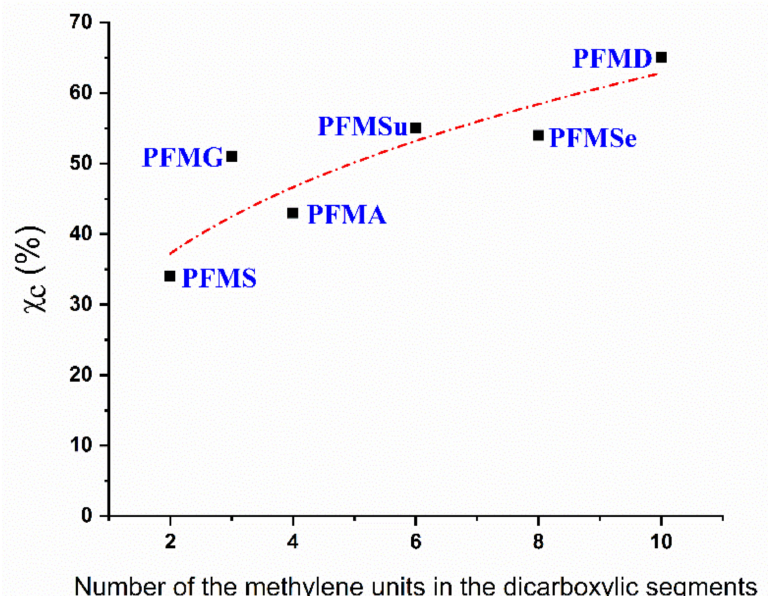
Figure 5. Degree of crystallinity ( χ C ) of the 1,5-bis(hydroxymethyl)furan-based polymers with varying number of methylene units in the diacid ethyl esters. Reprinted with permission from reference [41]. Copyright 2014 American Chemical